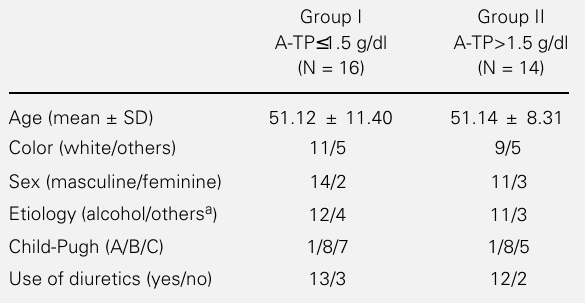
Table 2 - Clinical and biochemical parameters used for Child-Pugh classification of cirrhotic patients grouped according to total protein concentration in the ascitic fluid